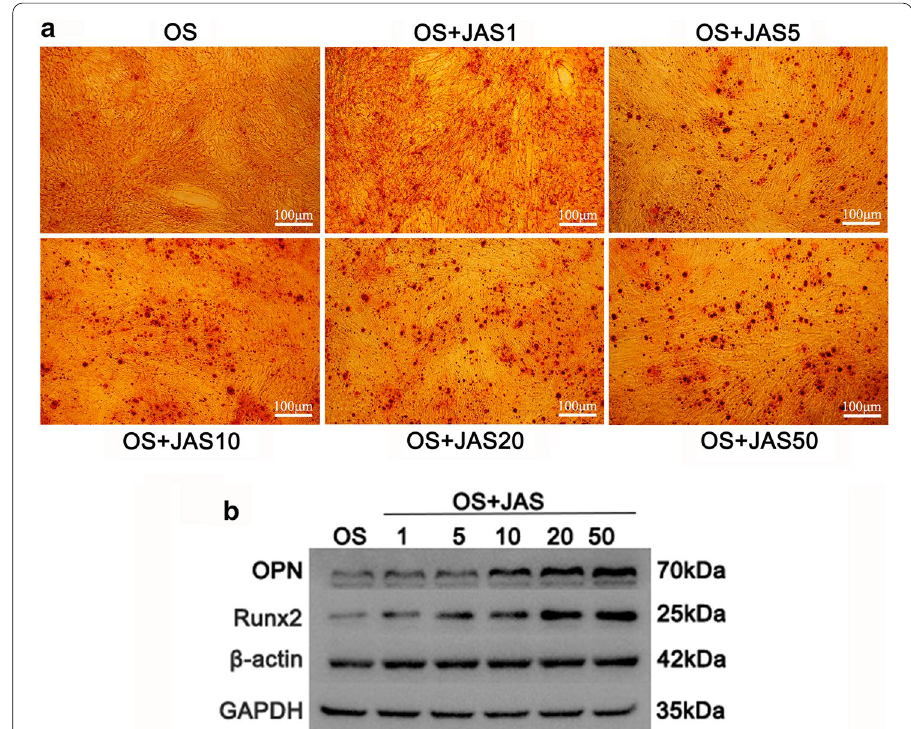
Fig. 7 Actin polymerization state and osteogenic differentiation of hASCs. a Cells were treated with osteogenic induction medium (containing different concentrations of JAS). They were then stained with alizarin red. b Western blot analysis for osteogenic markers of hASCs cultured in the osteogenic induction medium (containing different concentrations of JAS). Samples were collected after one week in culture. Quantification of western blot data was performed by Gel-pro software. The relative expression of these proteins was normalized to that of GAPDH. Results are expressed as mean